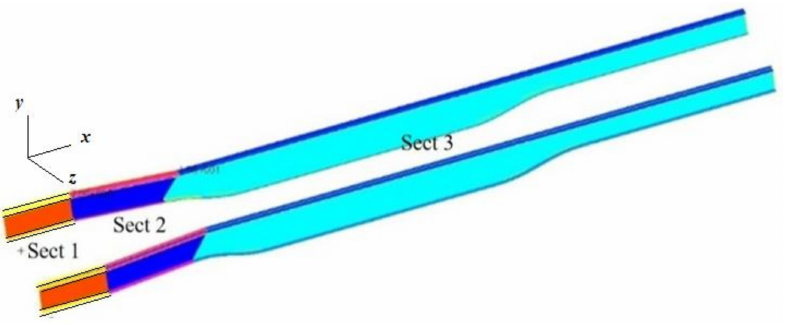
Figure 2. Rails divided into three sections with different thicknesses (shown using different colors).